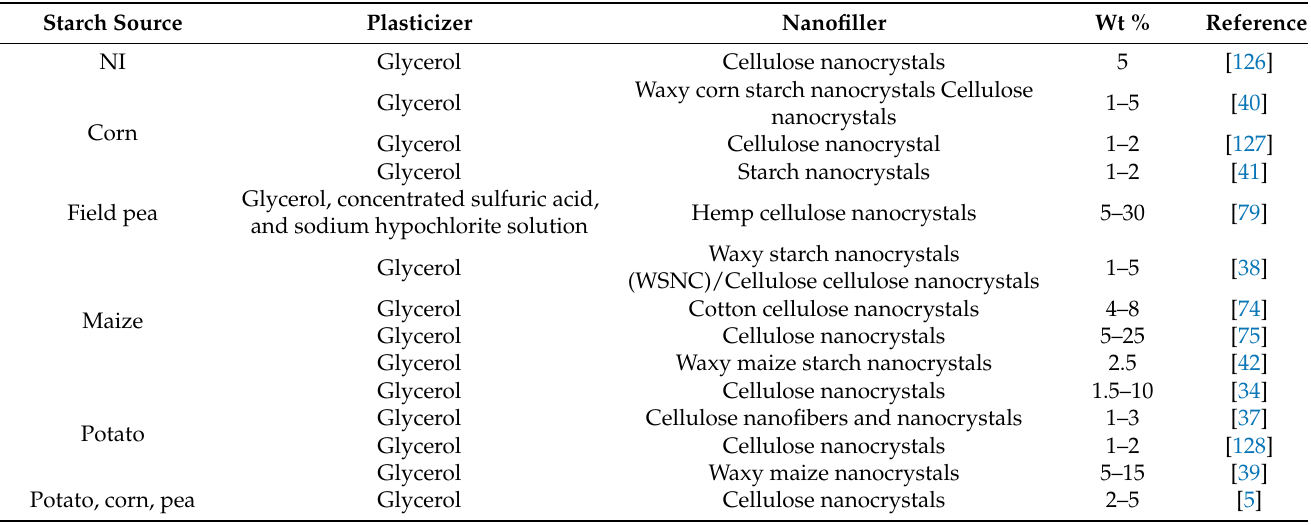
Table 2. Plasticizers and cellulose nanocrystals as nanofillers (including their wt %) in most used TPS sources. Starch